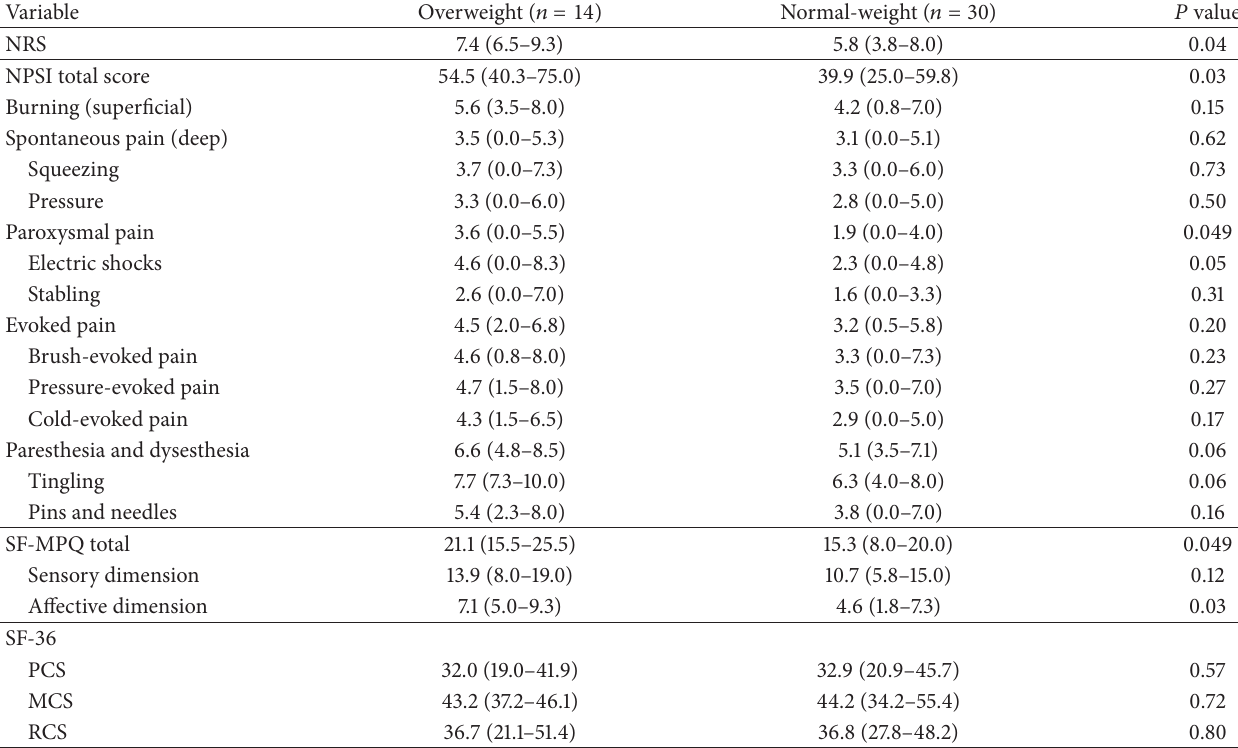
Table 2: Impact of body-weight on pain intensity, patient-reported symptoms, and quality of